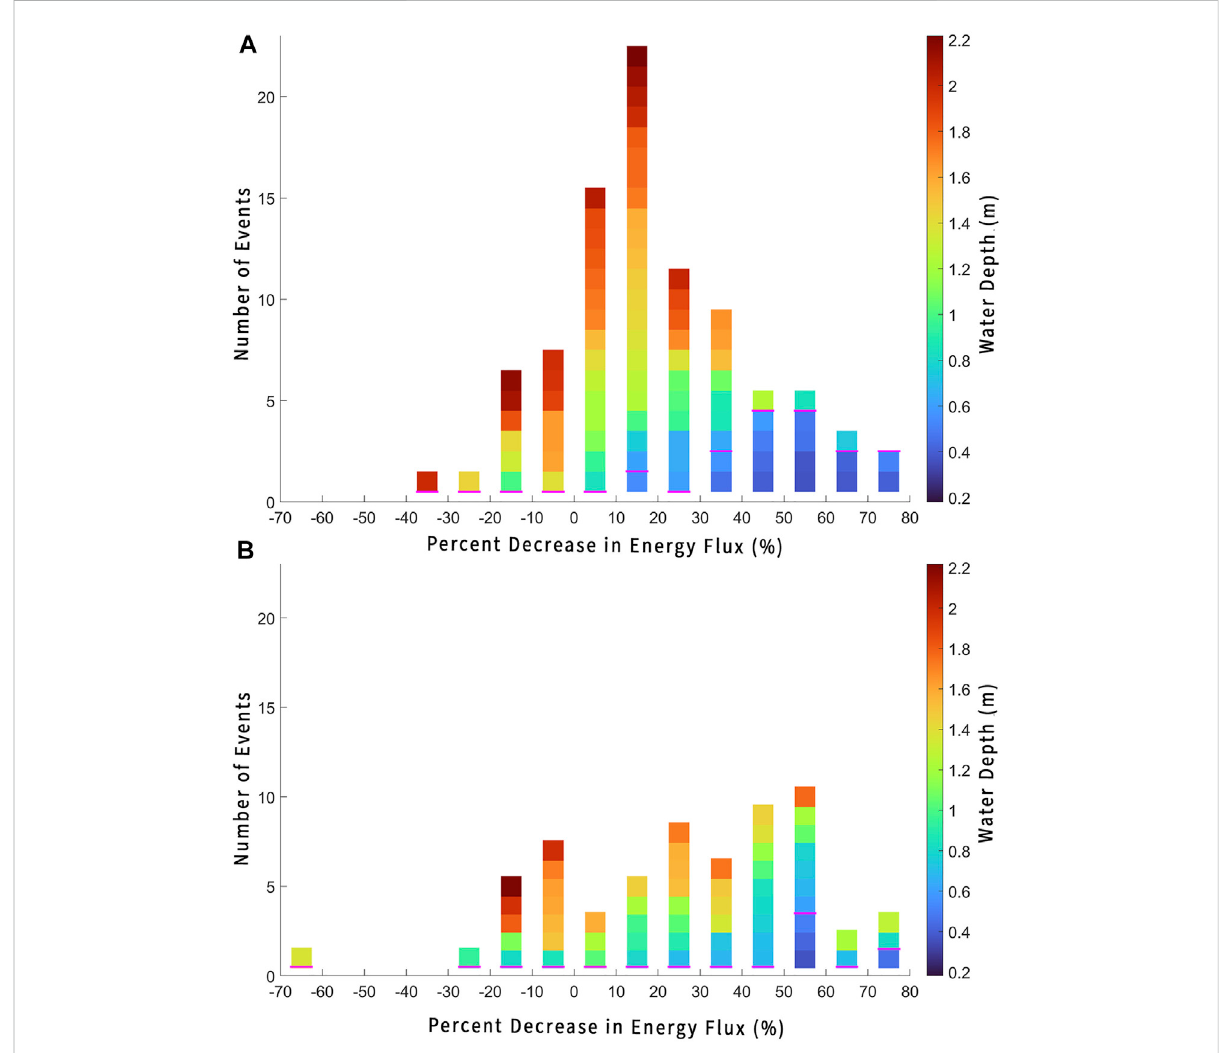
FIGURE 11 Histograms of percent decrease in energy fl ux from C4 to C1 for (A) southbound and (B) northbound ship wake events. Color represents water depth at sensor C4 for the event. Events above the magenta line take place with the heads of the THGs